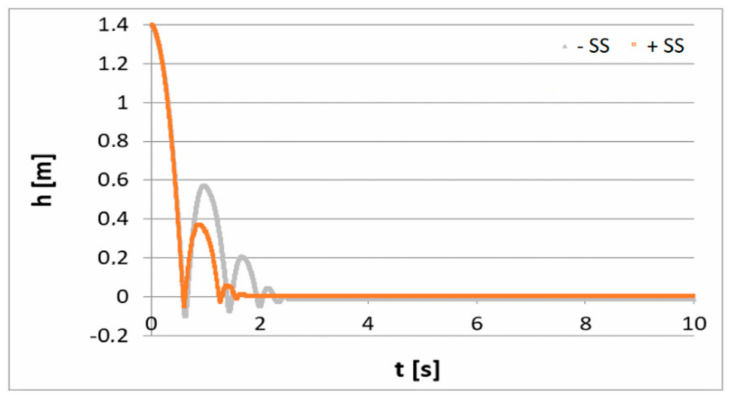
Figure 7. Comparison of the impact process times.